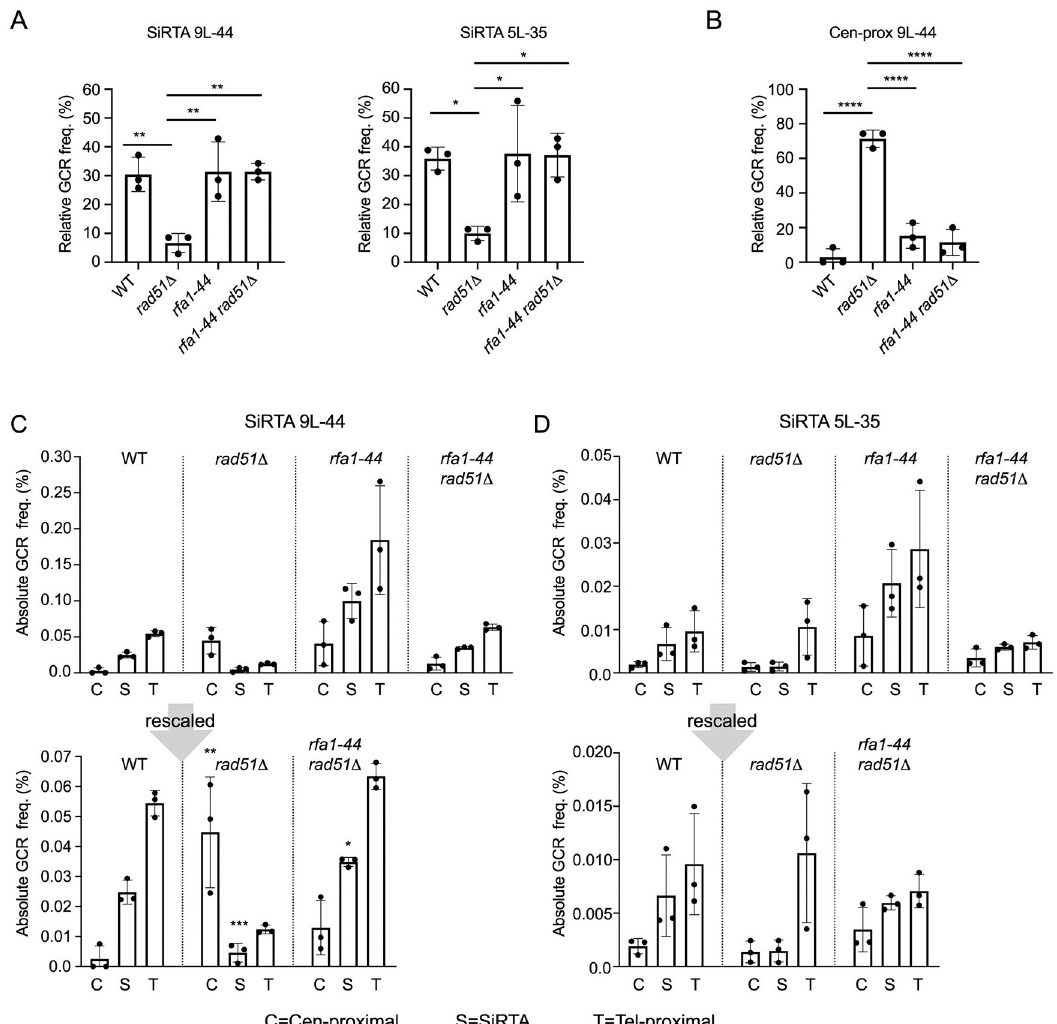
Fig 7. Disruption of the Rad52-Rfa1 interaction suppresses the de novo telomere addition defect of rad51 Δ . (A) The relative GCR frequency in SiRTA 9L-44 and 5L-35 is shown for the indicated strains. (B) The relative GCR frequency in the region centromere-proximal to SiRTA 9L-44 is shown for the same experiments presented in panel A (left graph). Averages and standard deviations are from three independent experiments. Averages indicated by asterisks are statistically different by ANOVA with Tukey’s multiple comparisons test. (C, D) Because the GCR frequency of the rfa1-44 strain is significantly higher than WT on both chromosomes 5 and 9, the absolute GCR frequency in each region of chromosome 9 (C) or 5 (D) is shown from the same experiments as panel A. Values are averages from three independent experiments with standard deviation. Results for the WT, rad51 Δ , and rad51 Δ rfa1-44 strains are shown on a different scale underneath. Statistical significance is only shown on the rescaled graph. For the centromere-proximal and SiRTA regions only, averages were compared to the WT sample in that same region by ANOVA with Dunnett’s multiple comparisons test ( � p < 0.05; �� p < 0.01; ��� p < 0.001; ���� p <